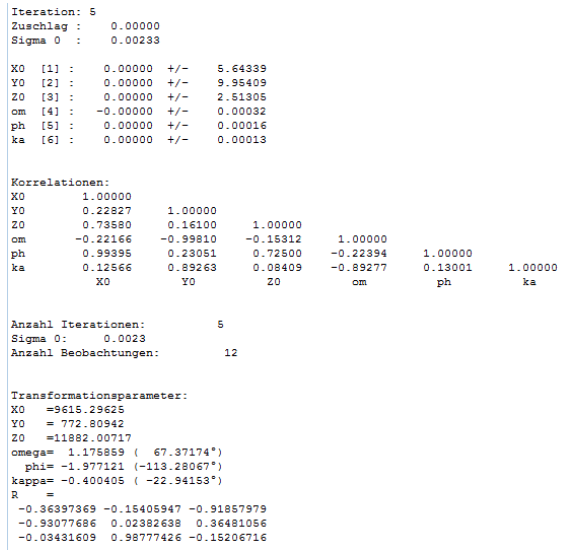
Figure 10: Log file for space resection